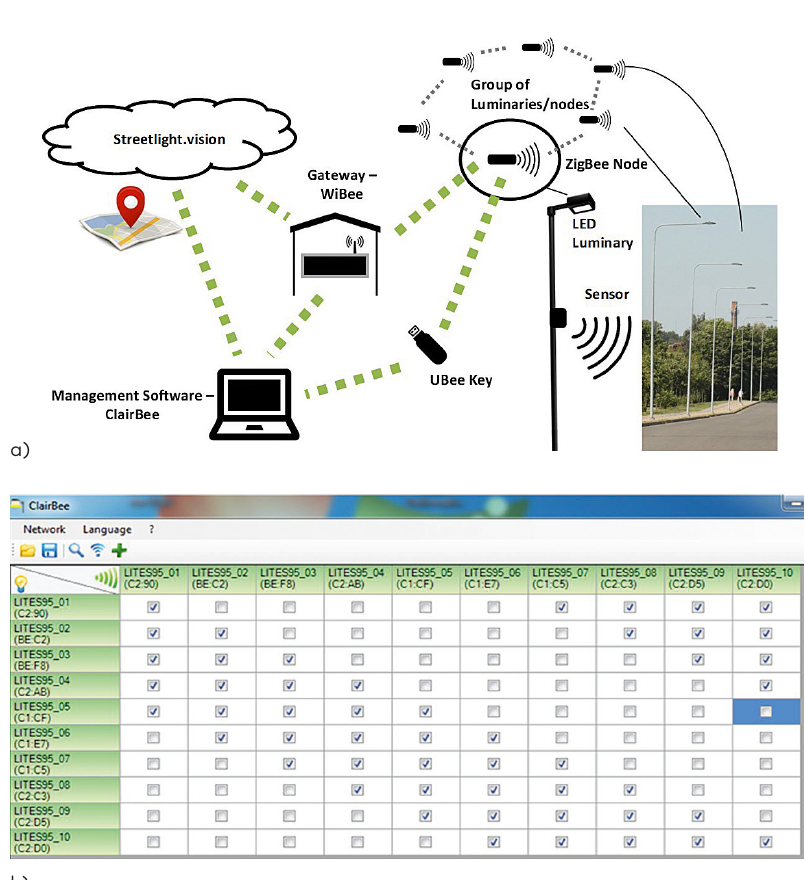
Figure 8. LITES smart LED lighting system (a), luminary network configuration